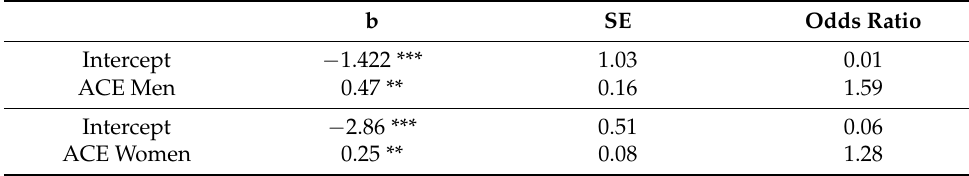
Table 14. Logistic regression model for IFV by sex.